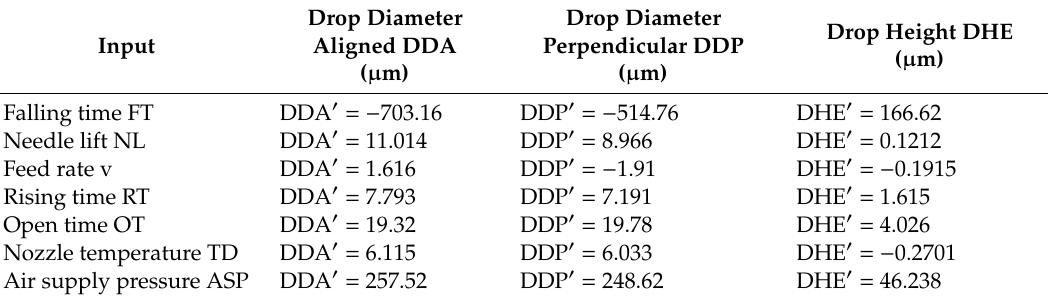
Table 1. Slopes at the starting points of the optimization in the preliminary tests.